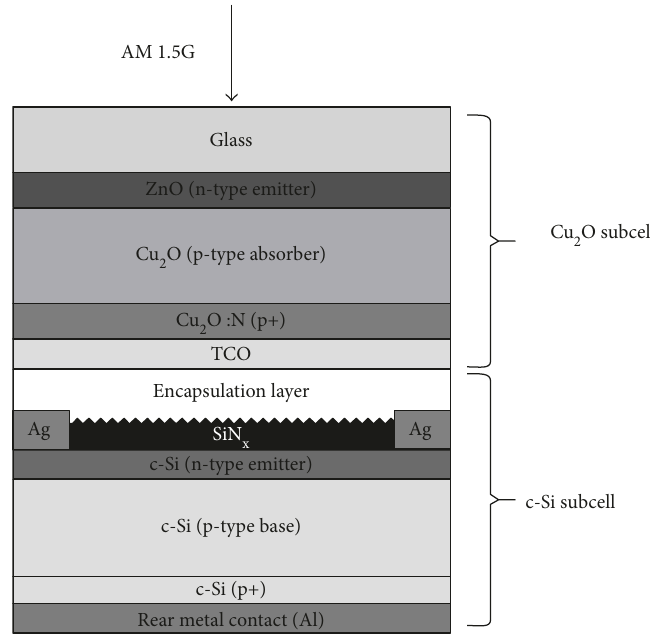
Figure 1: Schematic con fi guration design of a tandem solar cell based on Cu